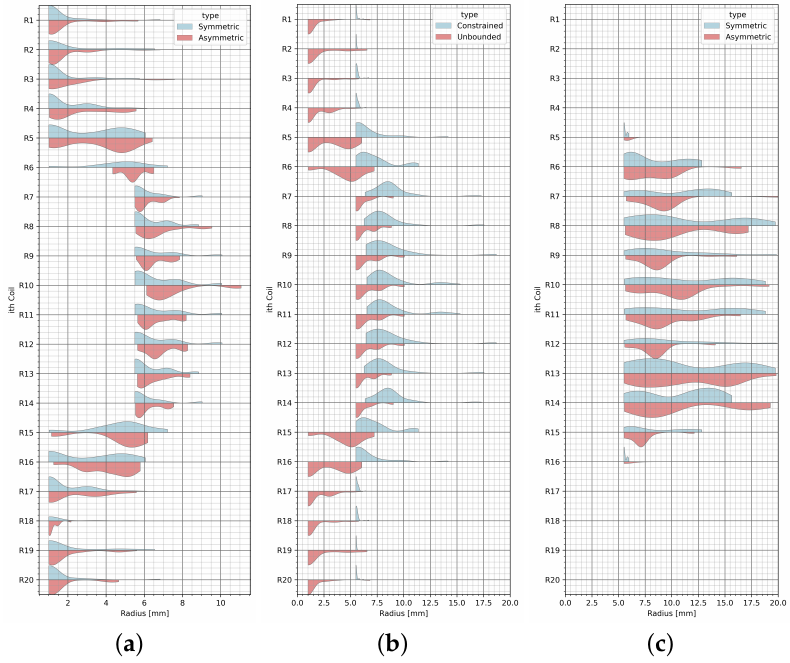
Figure 10. The distribution of the radii of the last 100 unsorted individuals. ( a ) Symmetric and asymmetric setups. All coils are allowed to move freely within the logical boundaries. ( b ) Only the symmetric setups where the coils are first allowed to move freely are shown (red); then, they are constrained in the 5.5–20 mm region (blue). ( c ) The distributions of the radii for the symmetric and asymmetric setups using only 12 coils. All coils were constrained to move within the 5.5–20 mm region.